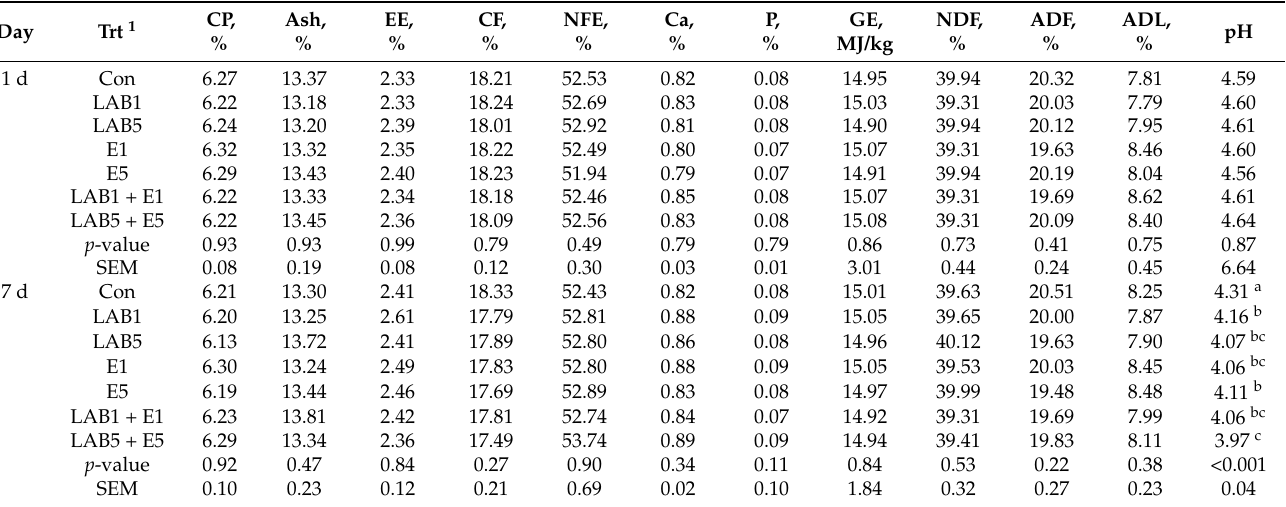
Table 2. Nutrient composition and pH of citric acid by-product at 1 and 7 days of fermentation.